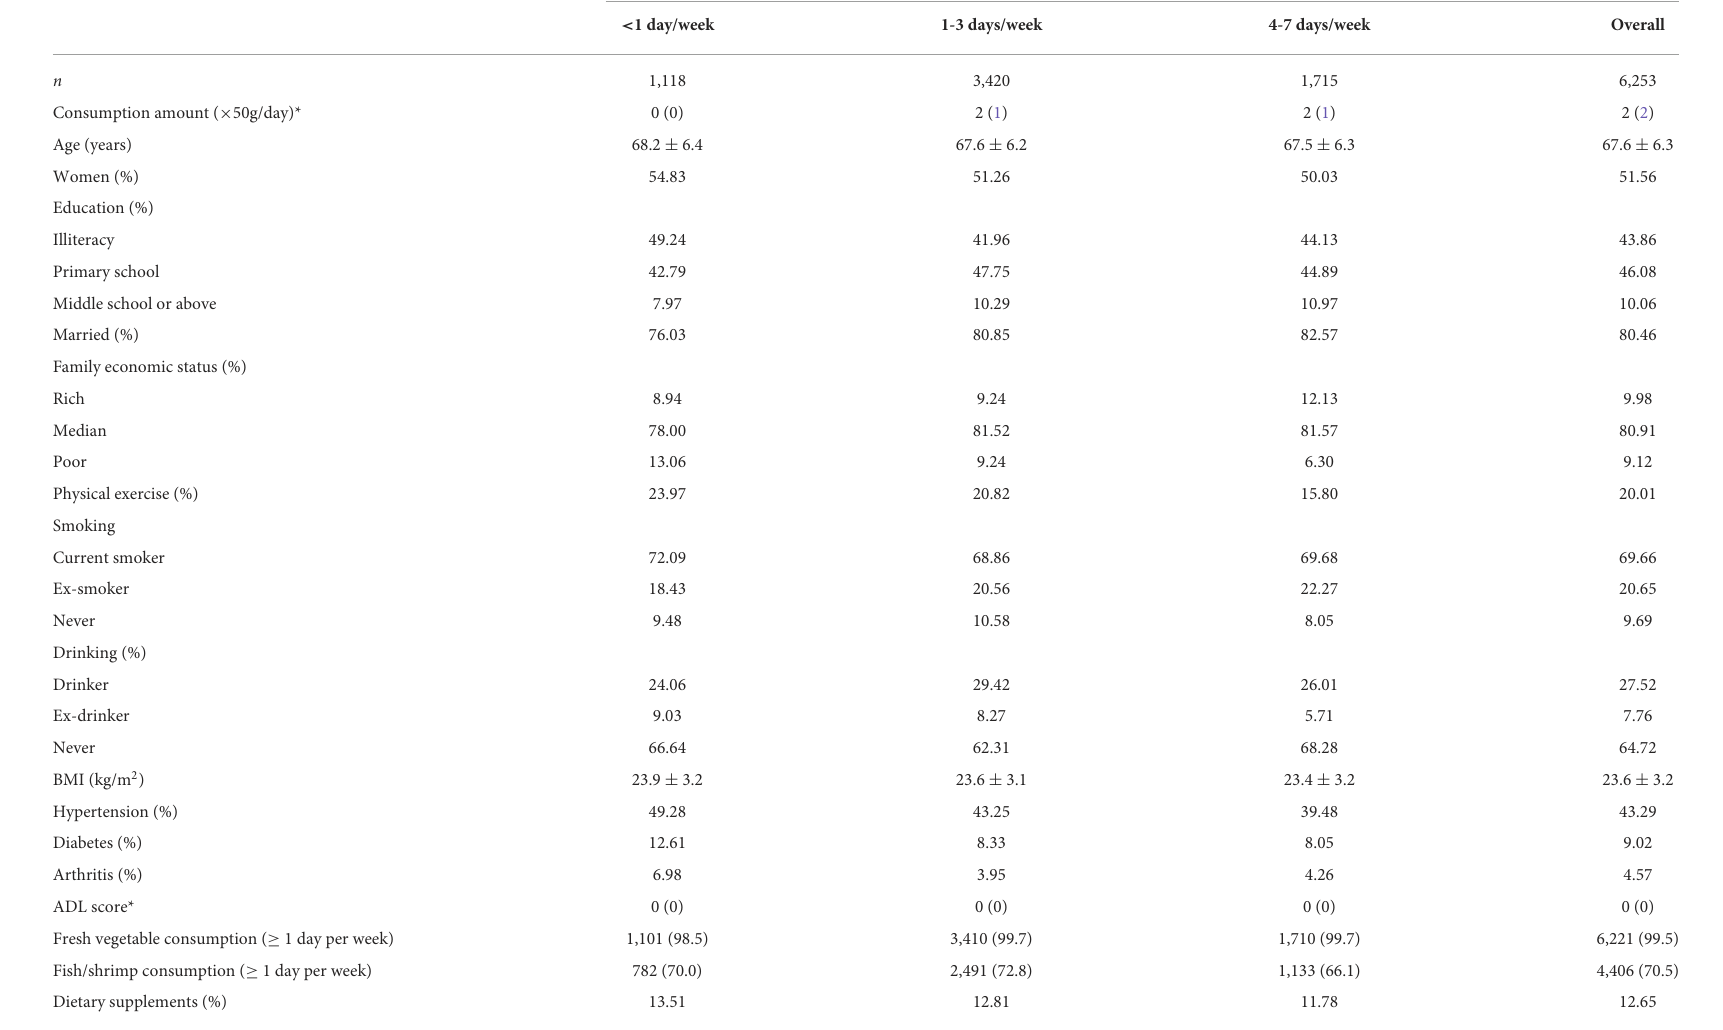
TABLE 1 Baseline characteristics by category of soy products consumption among 6,253 participants.